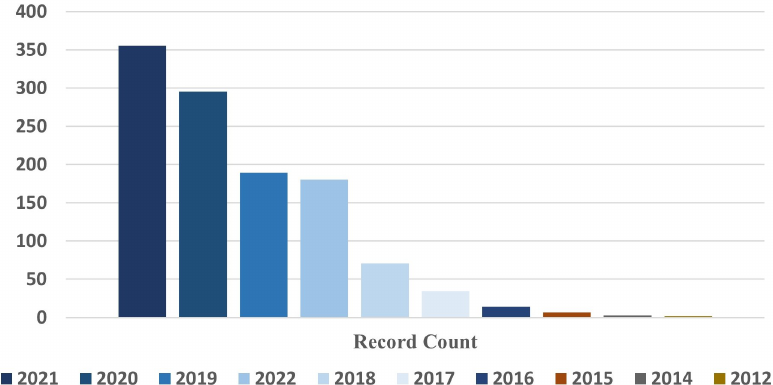
Figure 1. Number of papers published on AI algorithms in the EHR field over the past decade. This area is receiving more attention from computer researchers every year.